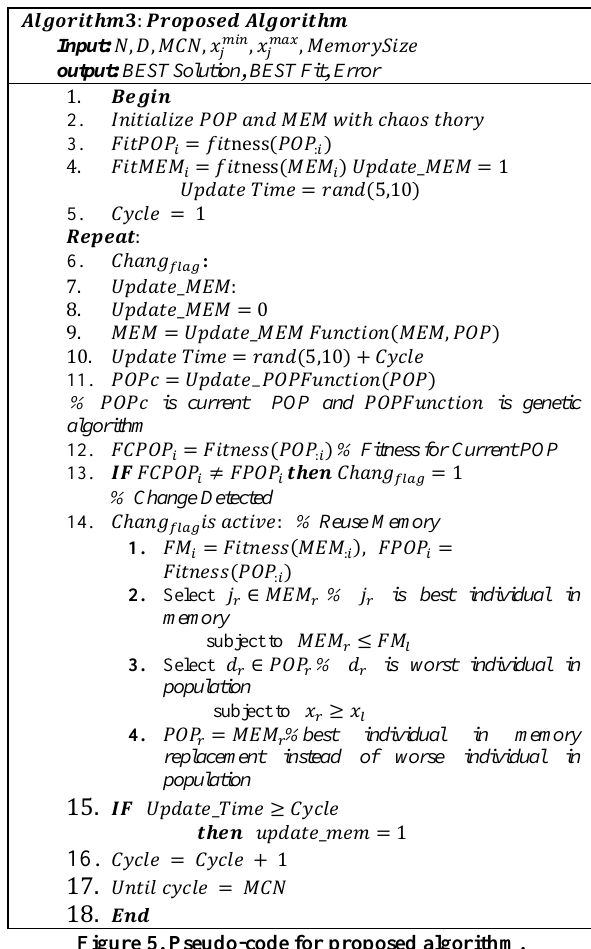
Figure 5. Pseudo-code for proposed